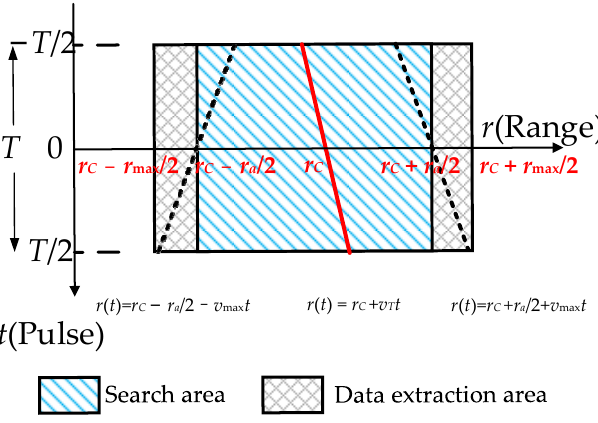
Figure 1. The across range cells (ARC) walk of a target.